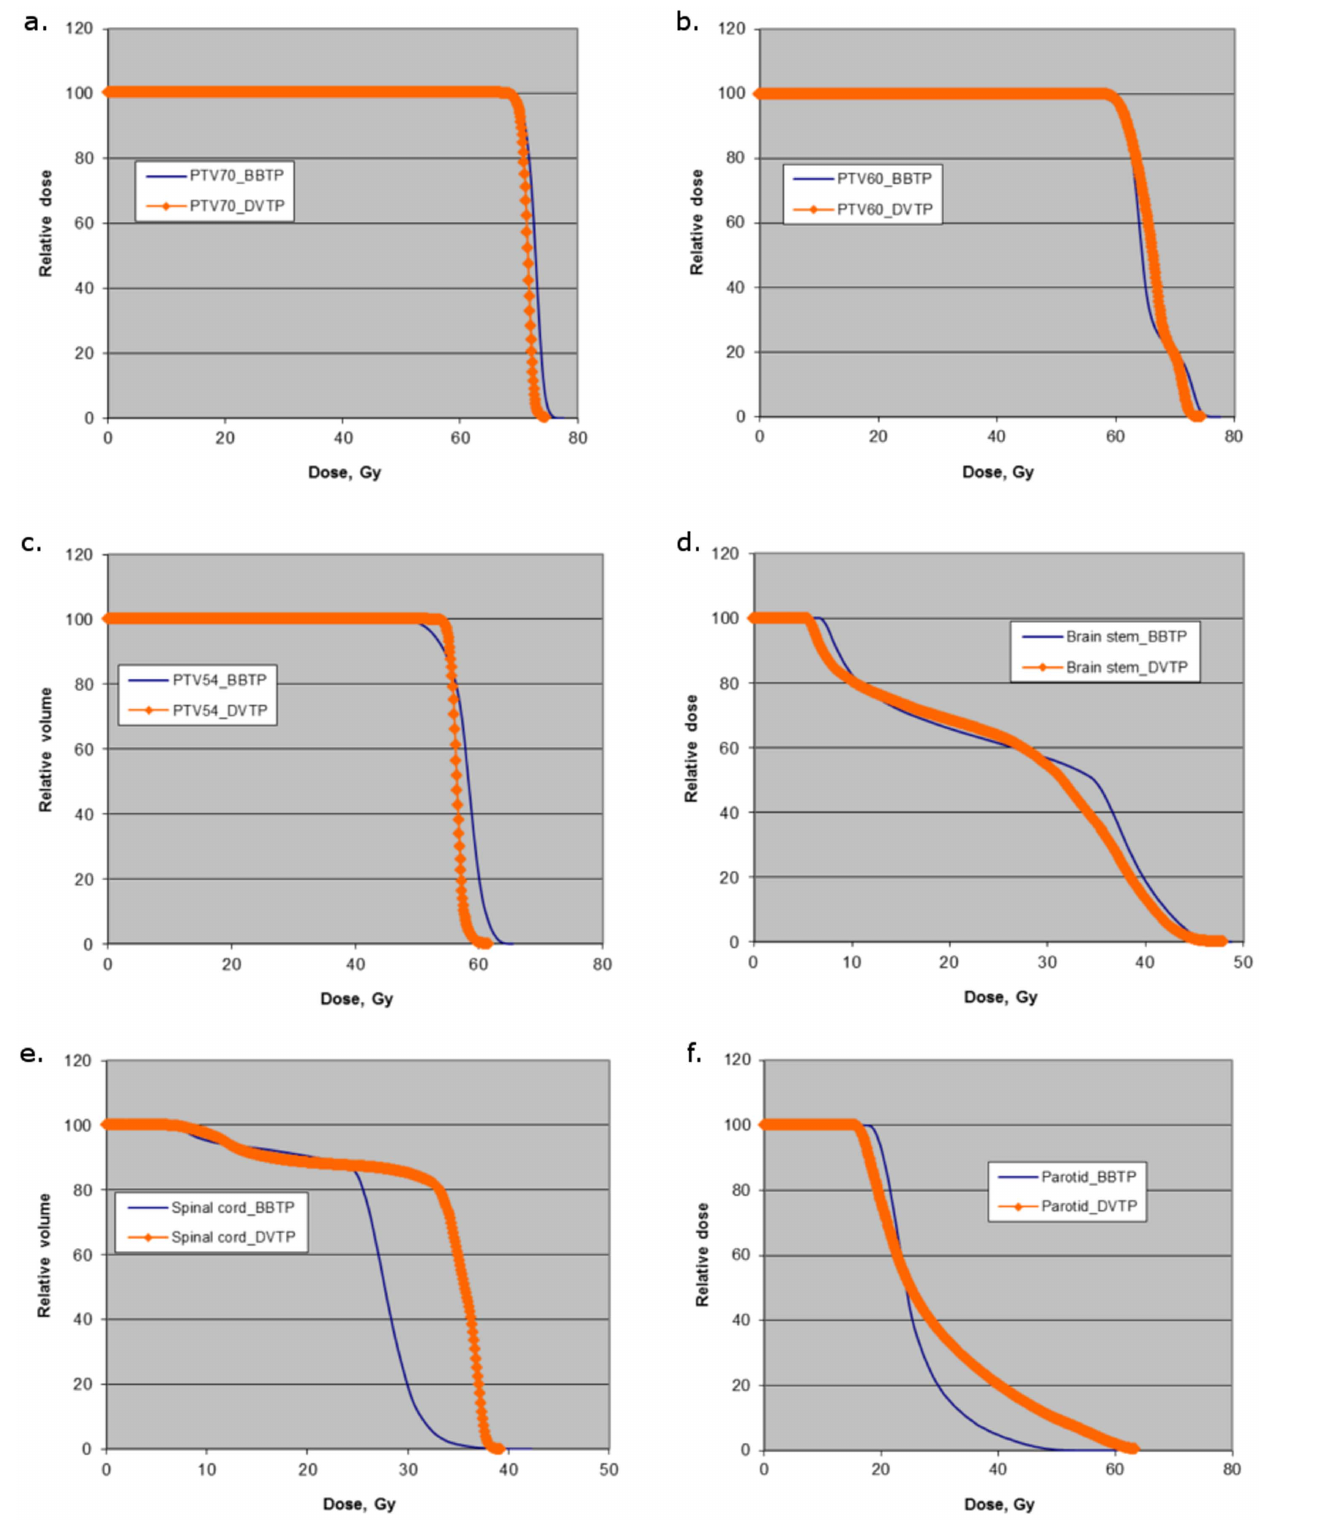
Figure 1. Comparison of the dose volume histograms between BBTP and DVTP plans for various targets including (a) PTV 70 , (b) PTV 60 , (c) PTV 54 and various OARs including (d) brain stem, (e) spinal cord, (f) parotid of a typical early stage NPC patient.